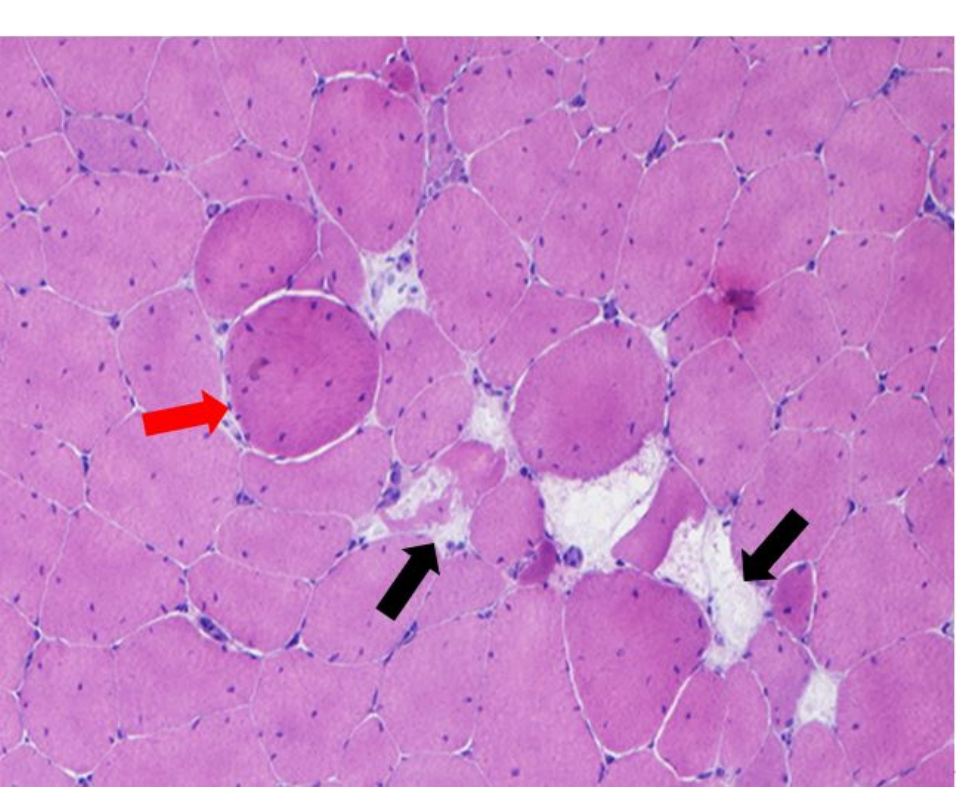
Figure 6. Ross 308 Pectoralis major with muscle fibers necrosis ( black arrows ) and giant fiber ( red arrow ). H-E, 200×.